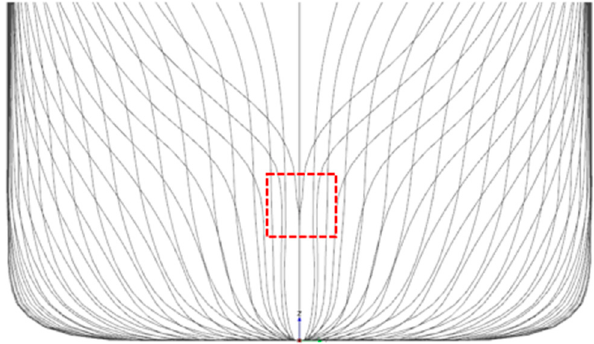
Figure 9. Line plan of reconstructed hull form KLE-3.